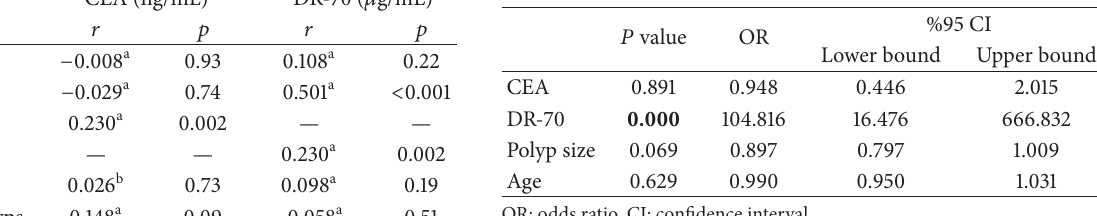
Table 3: Factors predicting high grade dysplastic polyps. Results of multiple logistic regression